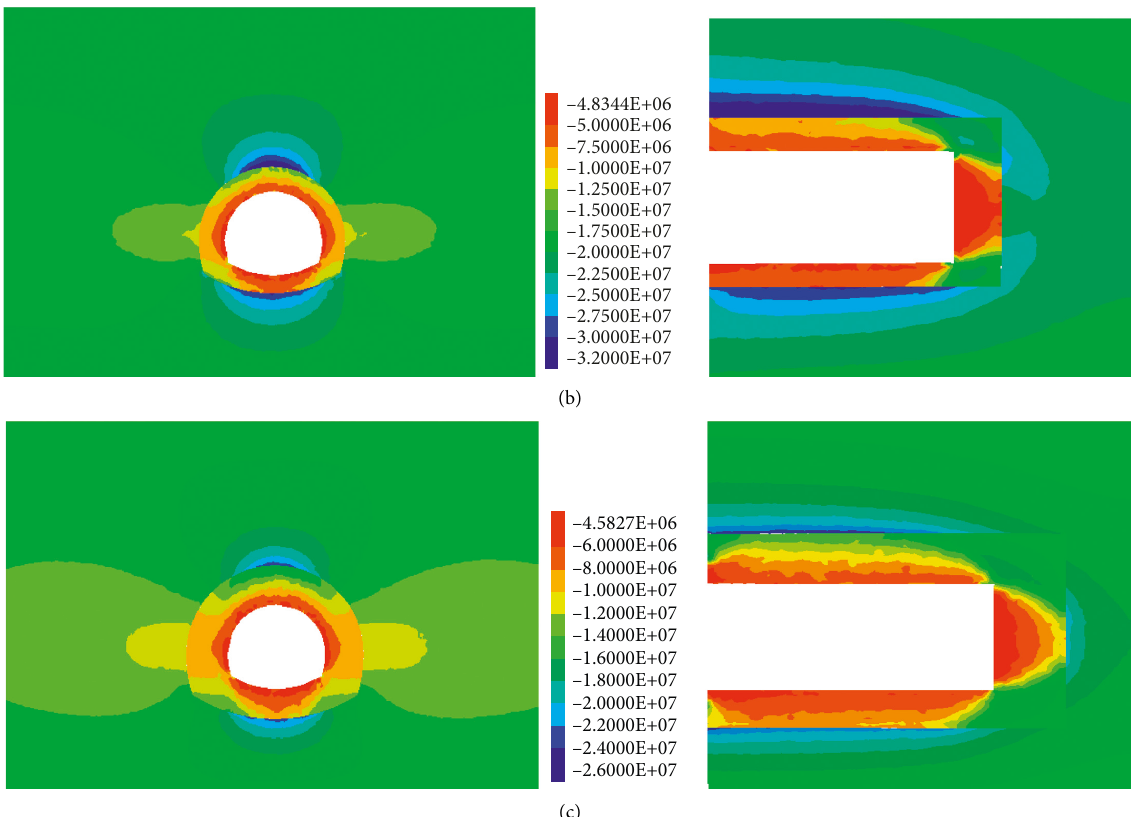
Figure 6: Distribution characteristics of maximum principal stress of surrounding rock. (a) Tunnel excavation without surrounding rock modification. (b) The modified depth 3 m. (c) The modified depth 5